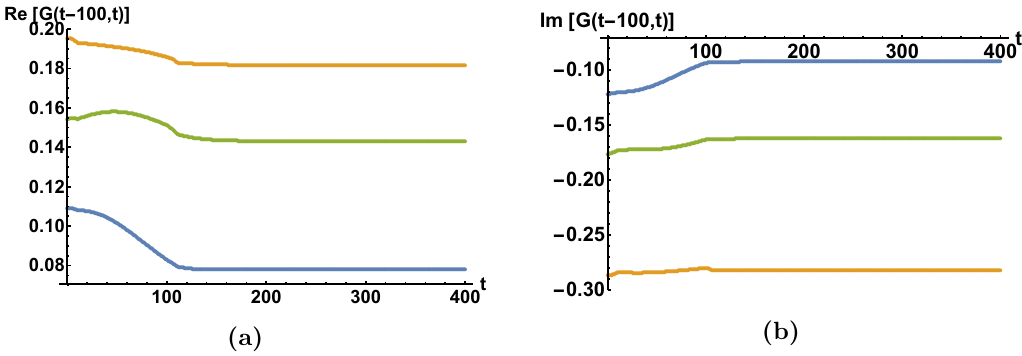
Figure 6. (a) Real part of the greater Green’s function G > ( t (cid:0) 100 ; t ) in the SYK model with quartic interaction and changing the quadratic interaction J 2 following bump protocol for three di(cid:11)erent set-up using di(cid:11)erent initial temperatures and di(cid:11)erent values of J 4 and J 2 . (b) Imaginary part of the same greater Green’s function G > ( t (cid:0) 100 ; t ).